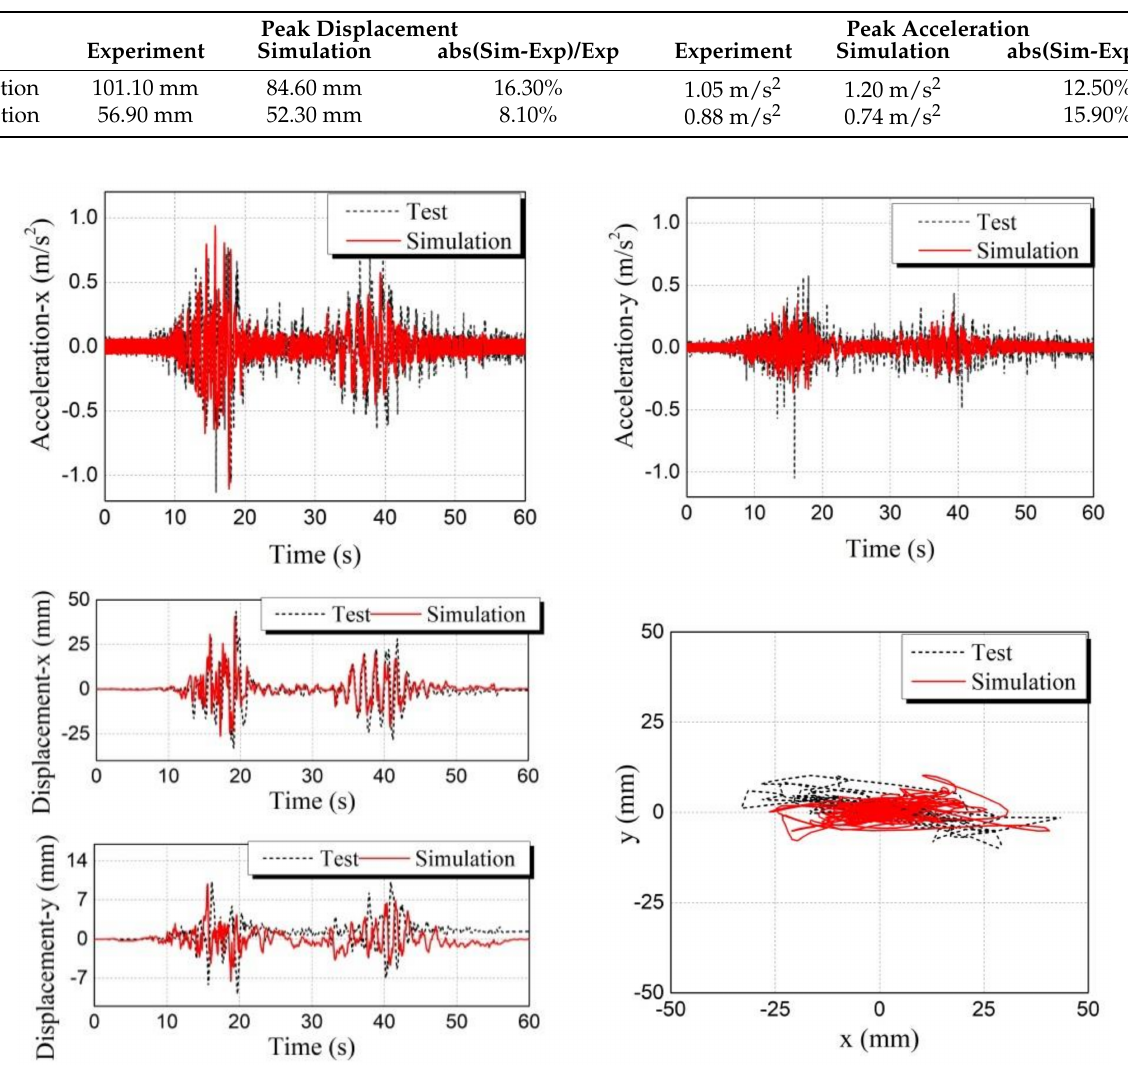
Figure 35. Comparisons between experimental and simulated results of the b300d380 bearing under Wo-long ground motion (high-frequency) with PGA of 6.2 m/s 2